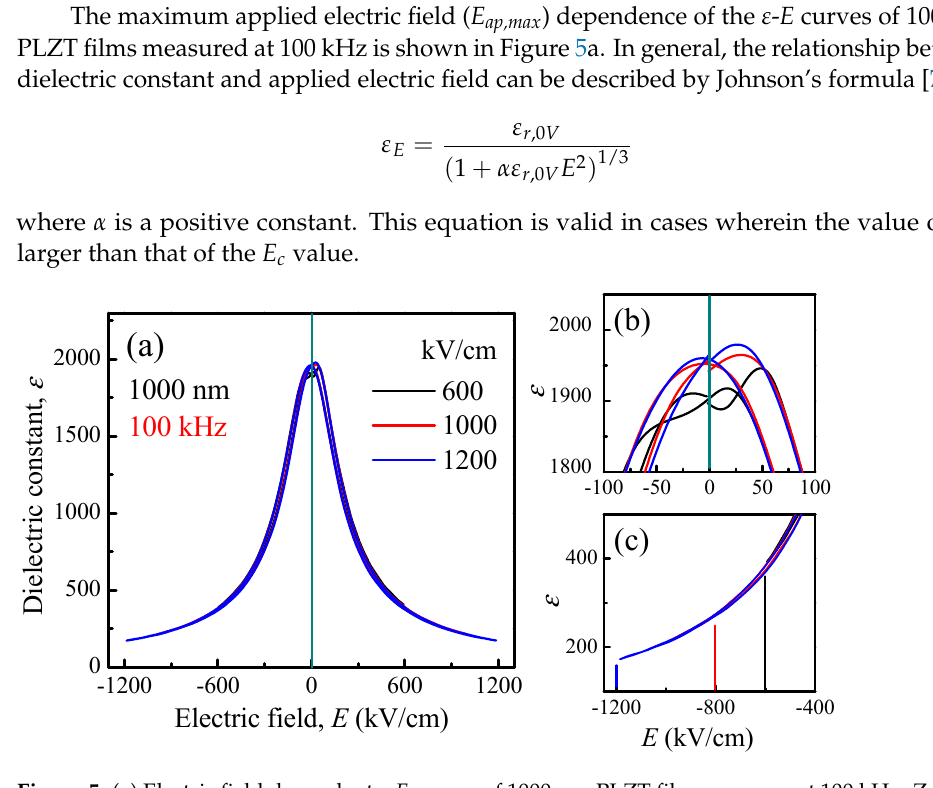
Figure 4. Operating frequency dependent ( a ) dielectric constant at zero field ( ε r,0V ) and at certain bias field ( ε Eap ), ( b ) dielectric loss at zero field (tan δ ), ( c ) tunability ( T ) and ( d ) figure-of-merit ( FOM ), of 1000-nm PLZT films. The measurements were done at 800 kV/cm.